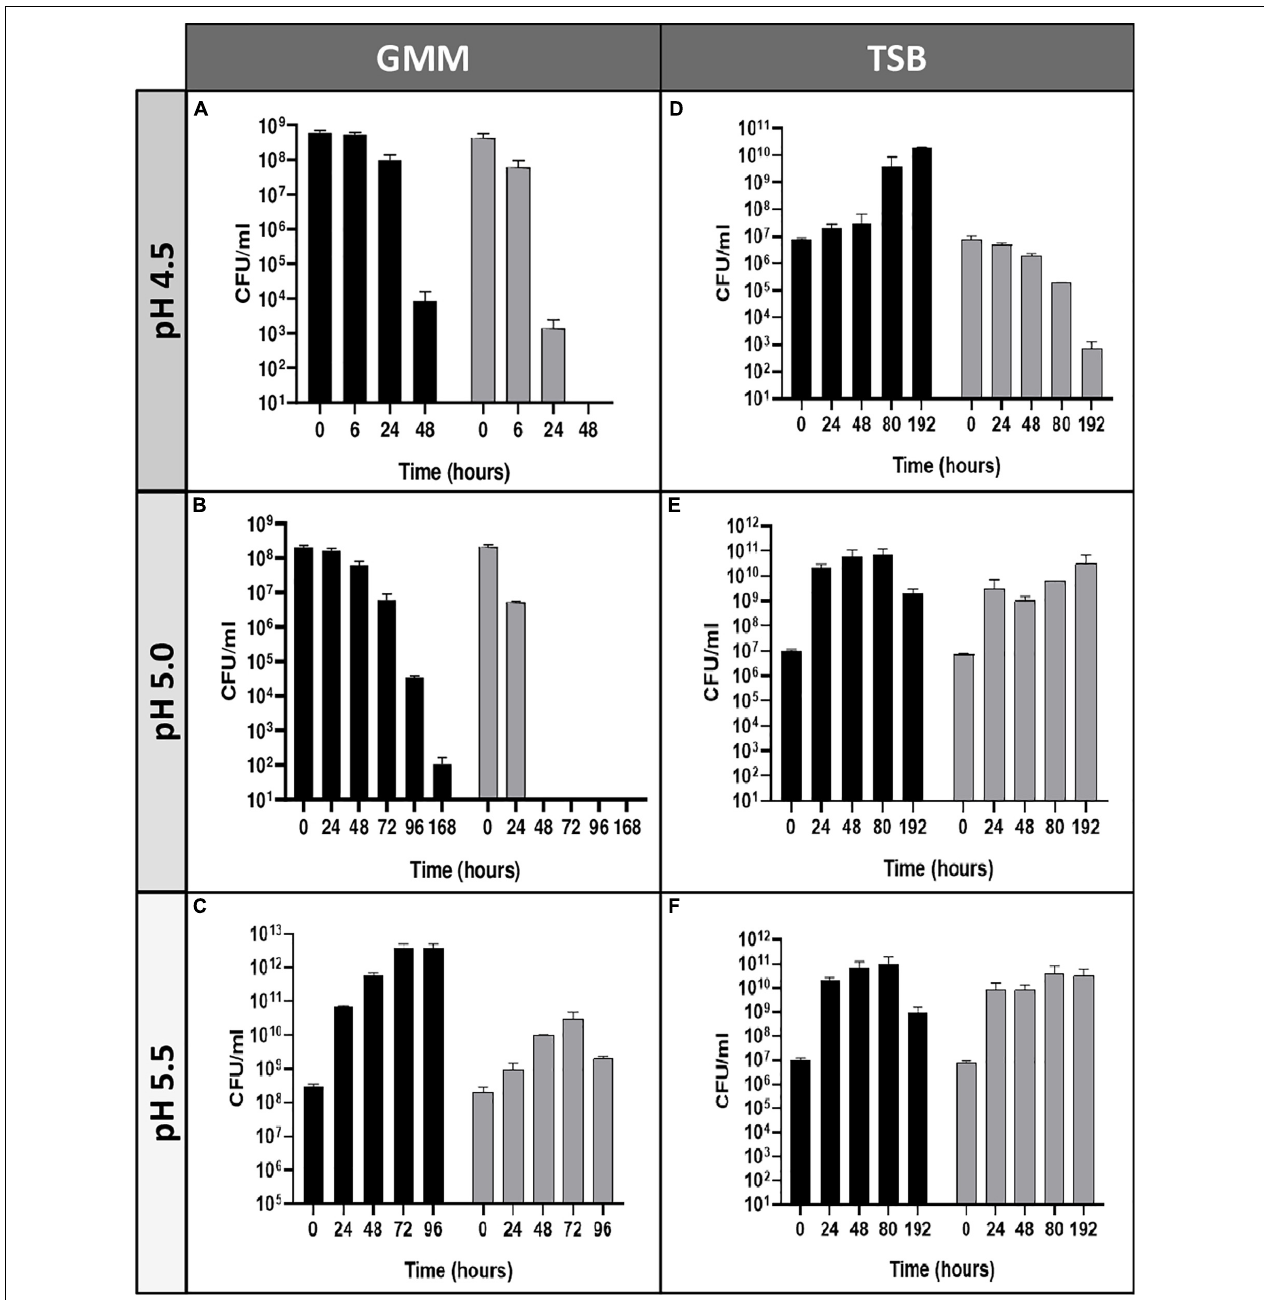
FIGURE 1 | Survival and replication of B. microti and B. suis in minimal or complex medium at pH 4.5–5.5. Viability of B. microti (black bars) and B. suis (gray bars) in modified Gerhardt’s Minimal Medium (A–C) or Tryptic Soy broth (D–F) adjusted to pH 4.5, 5.0, and 5.5 was determined at different time points. Values are shown as means of 3 experiments ± standard deviations